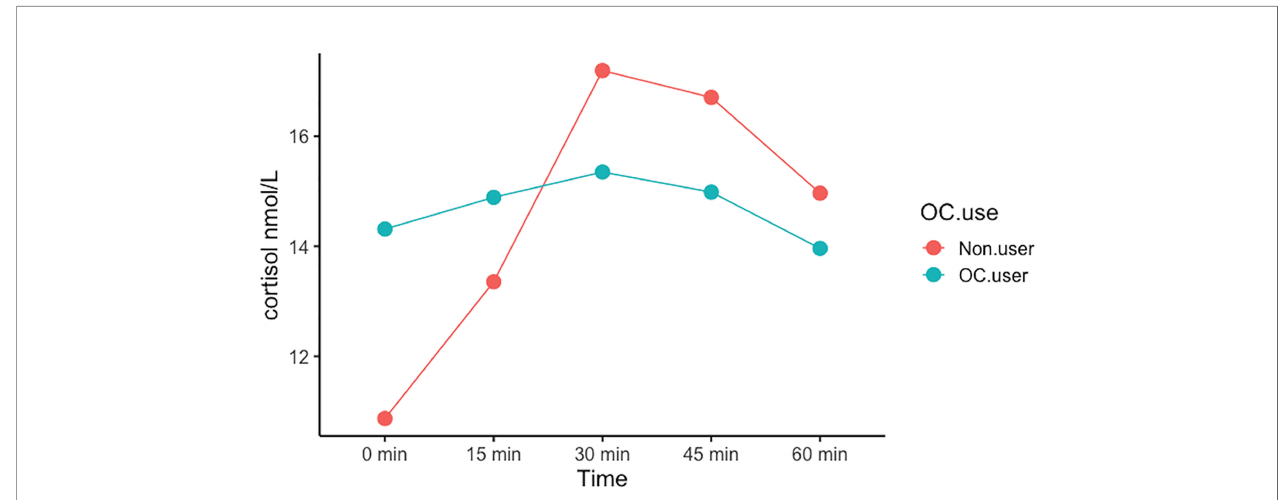
FIGURE 3 | The cortisol awakening response in OC-users and non-users. Mean cortisol values at each time point during the fi rst hour after wake up (0 min) depicting the cortisol awakening response. The 95% con fi dent intervals are presented as the shadowed area surrounding the